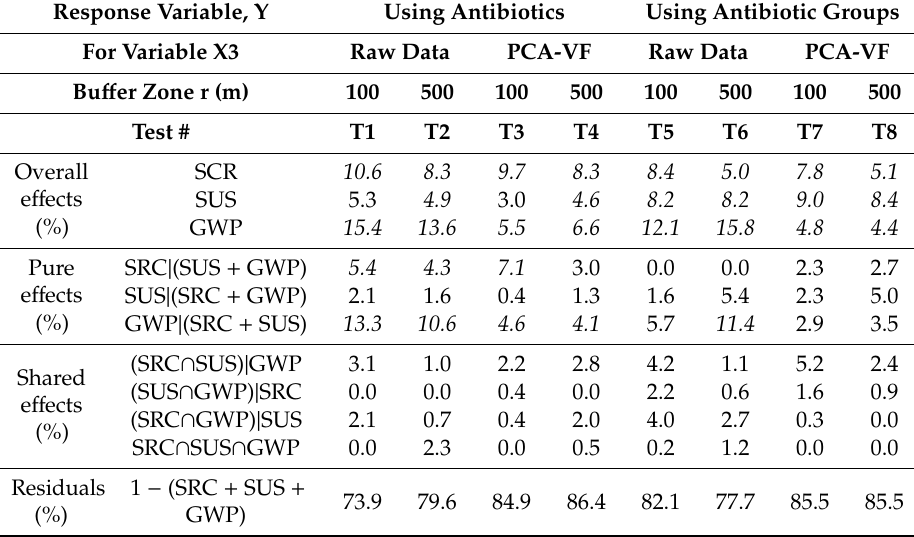
Figure 3. Flow chart of the variable examination and aggregation processes and the distinct combination of variables used for the di ff erent tests (T#) conducted in redundancy analysis (RDA) and variation partitioning (VP) statistical analyses. Test numbers (T#) are later on used in Tables 2 and 3 and Figure 5. Table 3. Results of the variation partitioning analysis (VP). Legend: | , pure e ff ects; ∩ , shared e ff ects; + , common e ff ects. See variable explanations in Table 1; “Raw data’ caption assumes that data has been transformed as mentioned in Section 2.3. Highlighted values (bold and italic) indicate significant proportions of variance explained for overall e ff ects or pure e ff ects (permutation test, p <